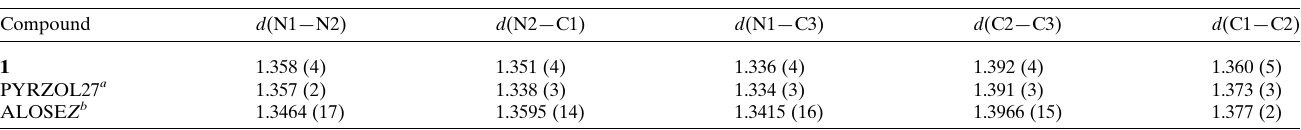
Table 1 Comparison of selected distances (A˚ ) in 1 with two comparable structures denoted by their CSD refcodes (Groom et al. , 2016). Atom labels as in Fig. 1. For PYRZOL27, a Z 0 of 2 is observed and only values for the first residue are listed here. Compound